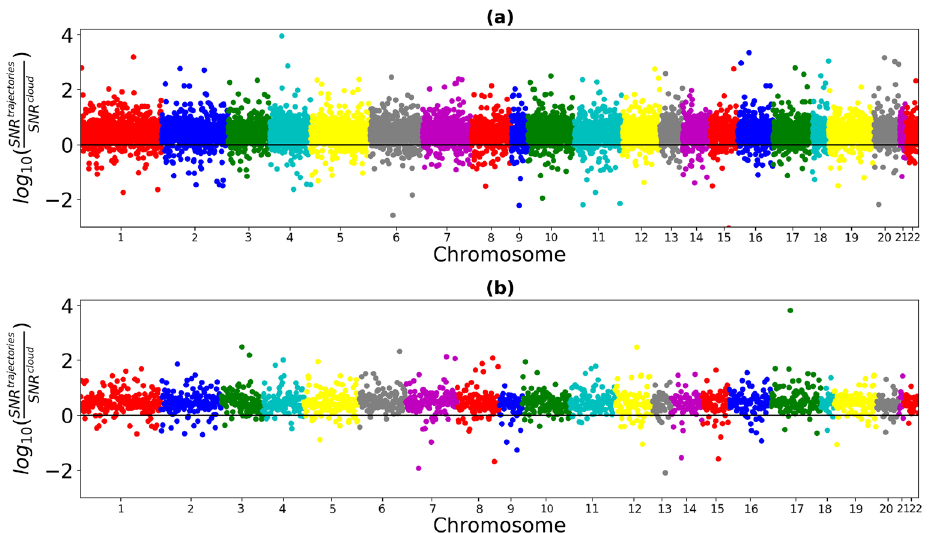
Figure 4. Manhattan plot of genome-wide logarithm of the ratio of the SNR of individual trajectories to the SNR of a cloud of beta values: top panel ( a ) - for males, bottom panel ( b ) - for females. The black lines are the zero value of the logarithm, that is, the situation when the SNR of individual trajectories and the SNR of a cloud of beta values are